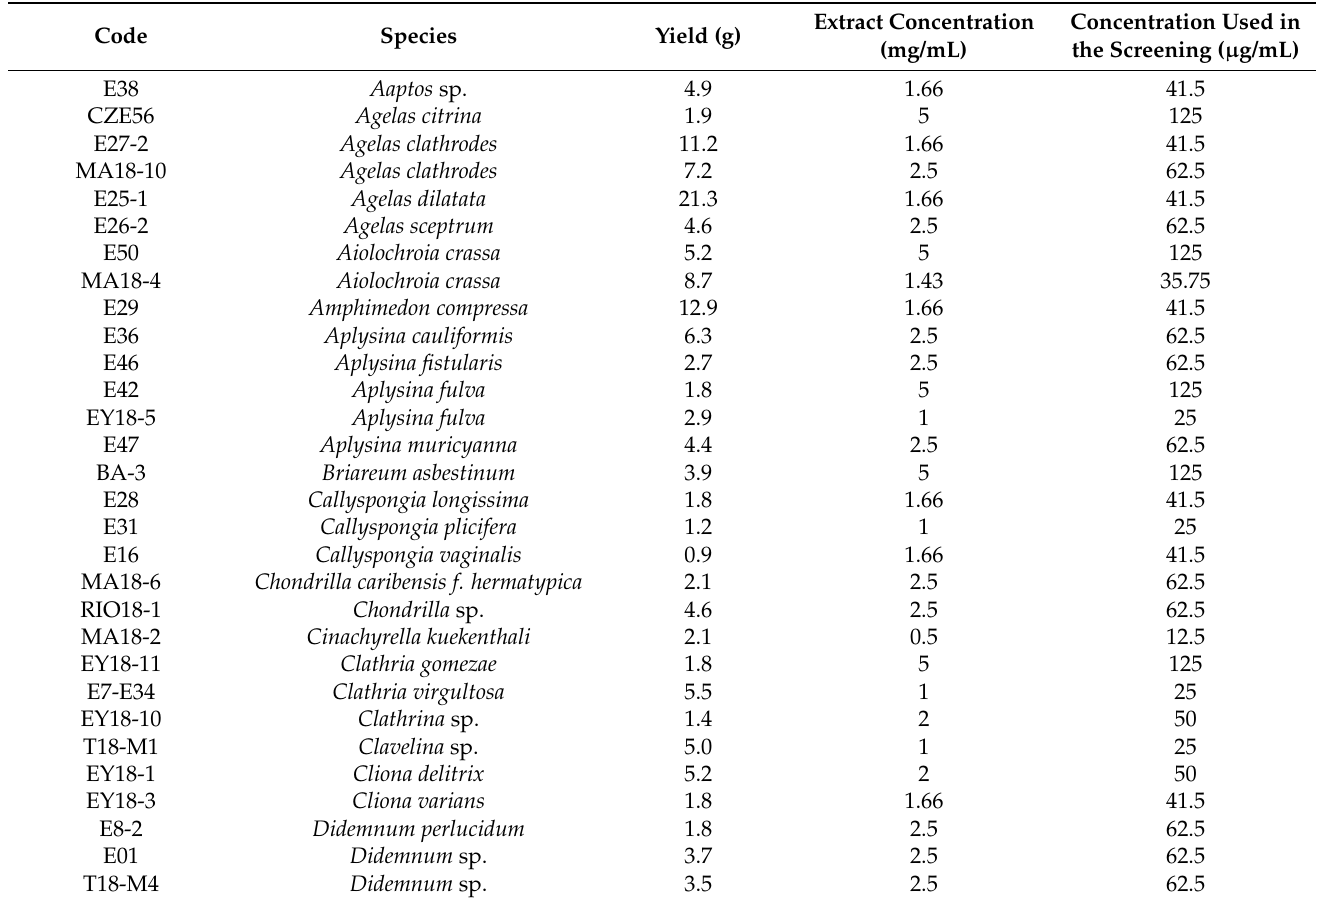
Table 1. Marine crude extracts tested for antifungal